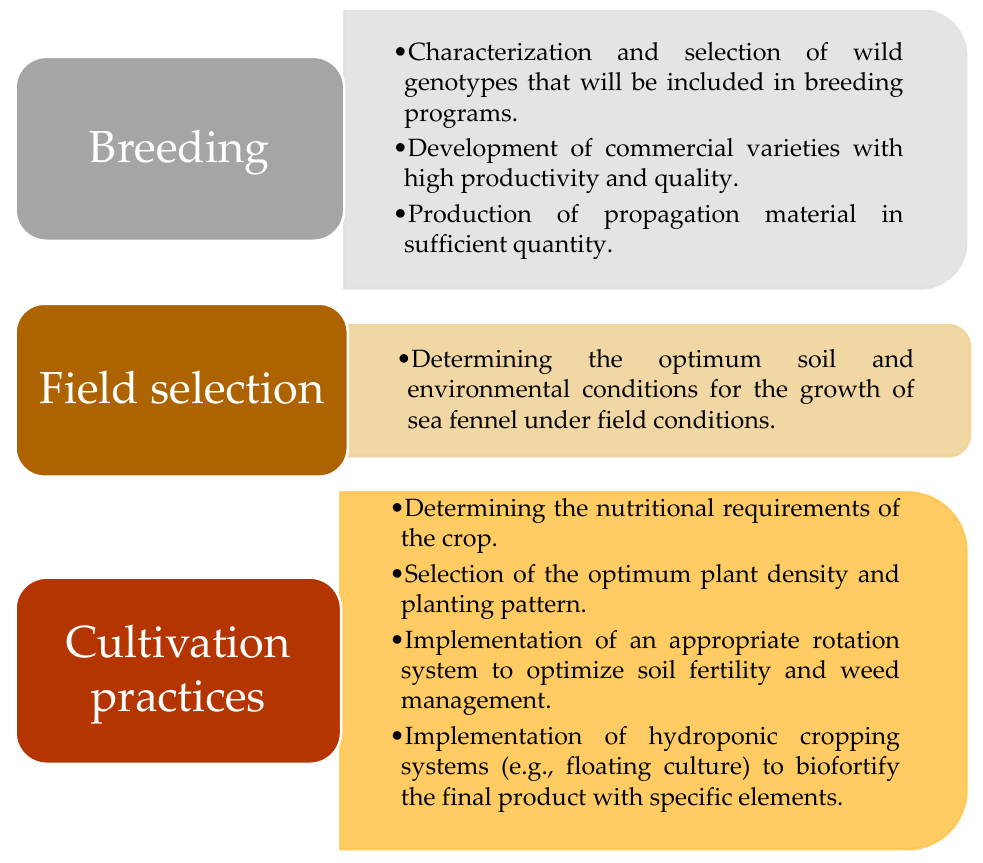
Figure 5. Optimization of biomass yield and quality of sea fennel under field and soilless conditions: Priorities and challenges.